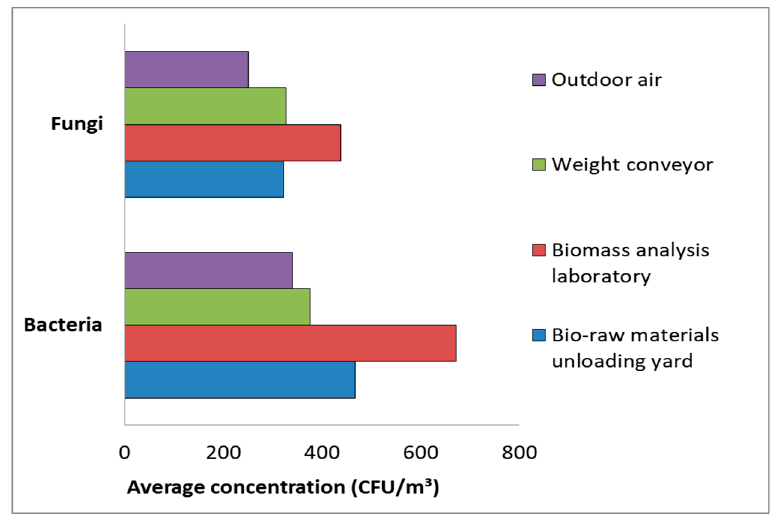
Figure 2. Indoor and outdoor average concentration levels (CFU/m 3 ) in different sampling points. The Mann-Whitney U test confirmed significant differences in the concentration levels of bacterial and fungal micro-organisms between the individual measuring stations and the outdoor air with p-values <0.05. The highest average concentration both of bacterial and fungal aerosol was recorded in the biomass analysis laboratory (673 CFU/m 3 and 438 CFU/m 3 , respectively). The lowest concentrations of biological aerosol were recorded in the outdoor air, where the concentration of airborne bacteria was 341 CFU/m 3 and fungi 251 CFU/m 3